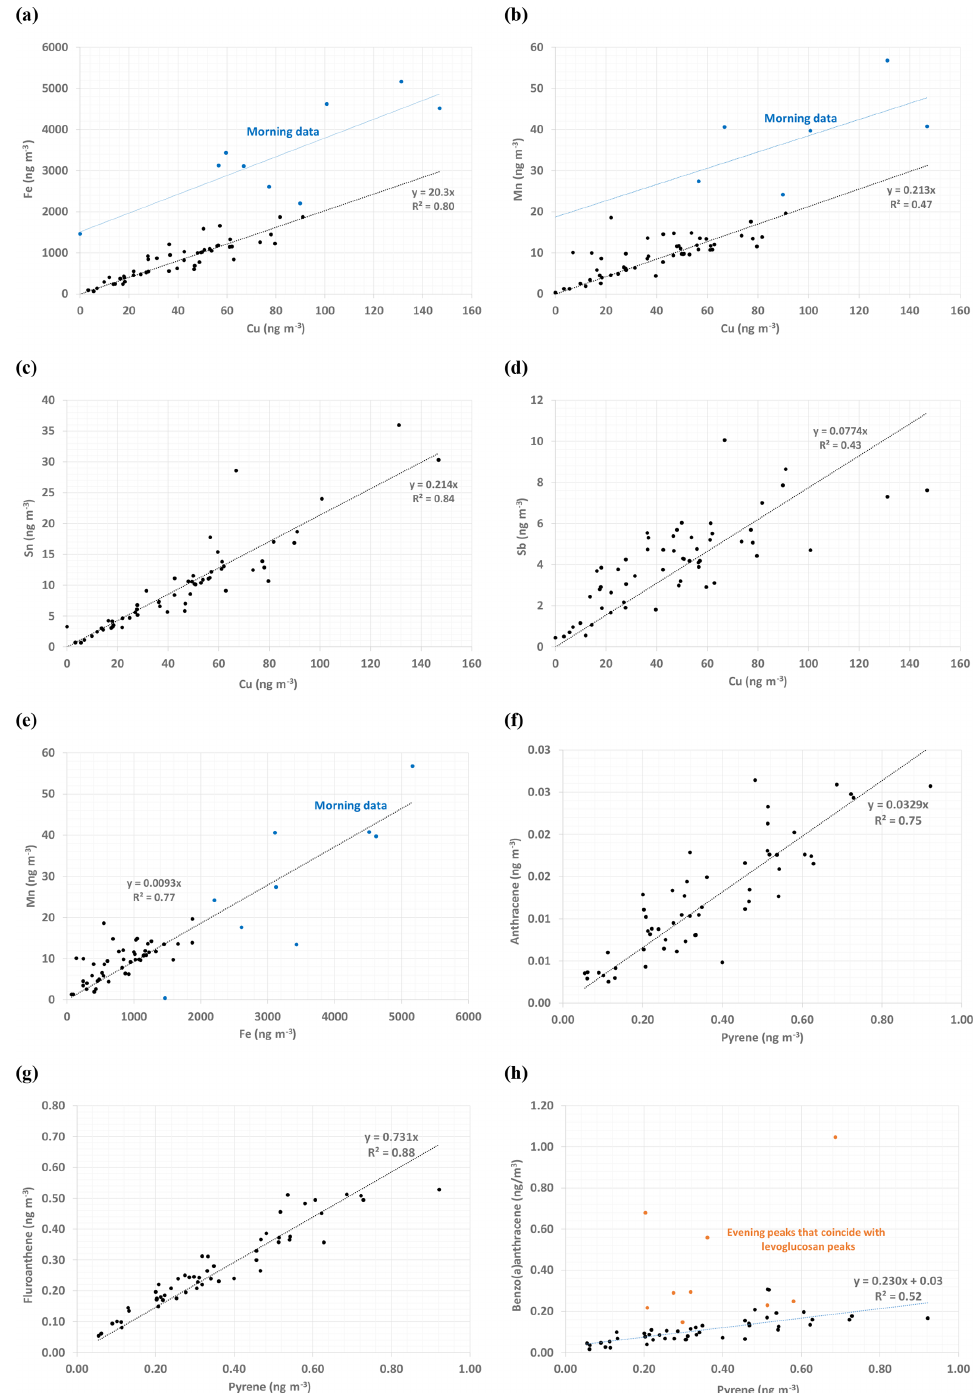
Figure 4. Scatterplots and linear relationships for a few species: (a) iron vs. copper, (b) manganese vs. copper, (c) tin vs. copper, (d) antimony vs. copper, (e) manganese vs. iron, (f) anthracene vs. pyrene, (g) fluoranthene vs. pyrene and (h) benzo(a)anthracene vs.